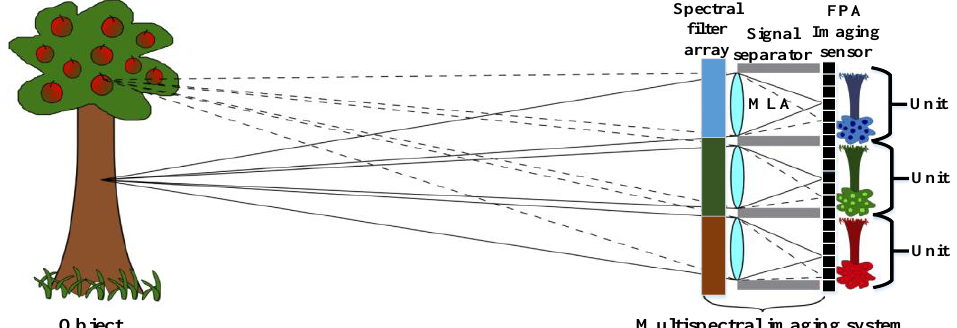
Figure 2. Working principle of multispectral compound eye snapshot imaging system.